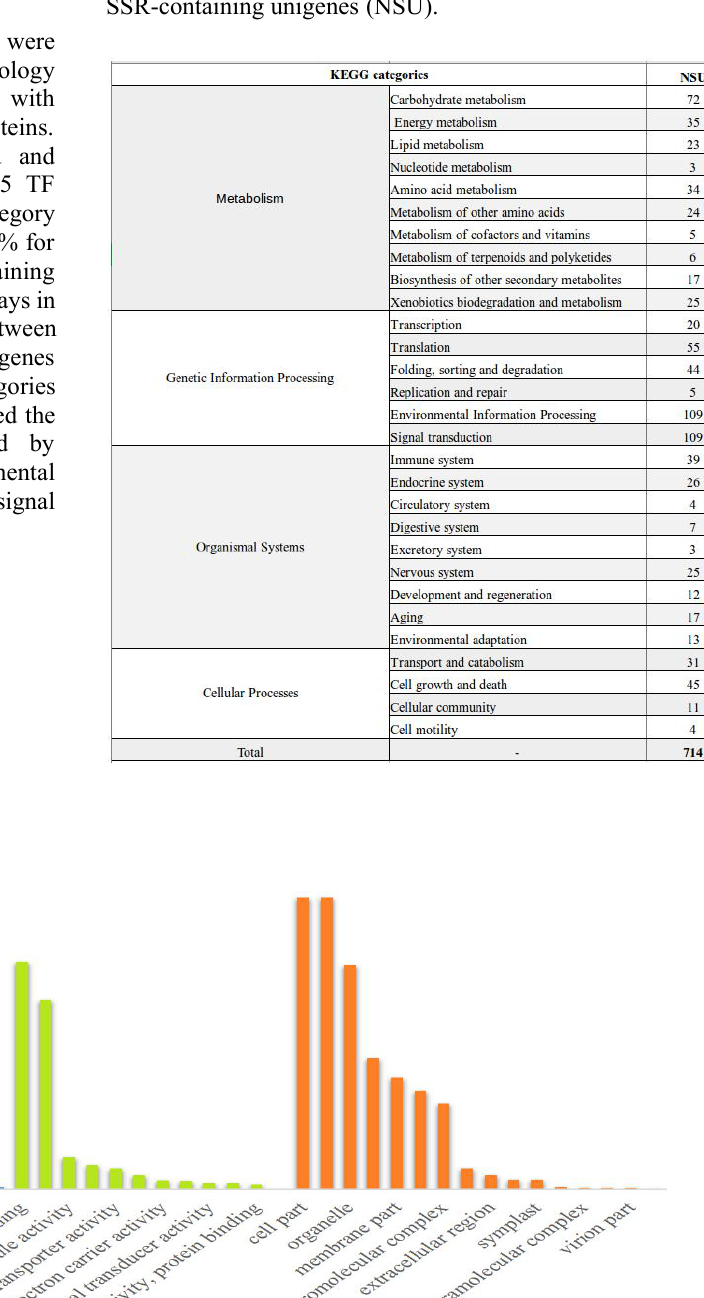
Table 2. KEGG classification results and Number of